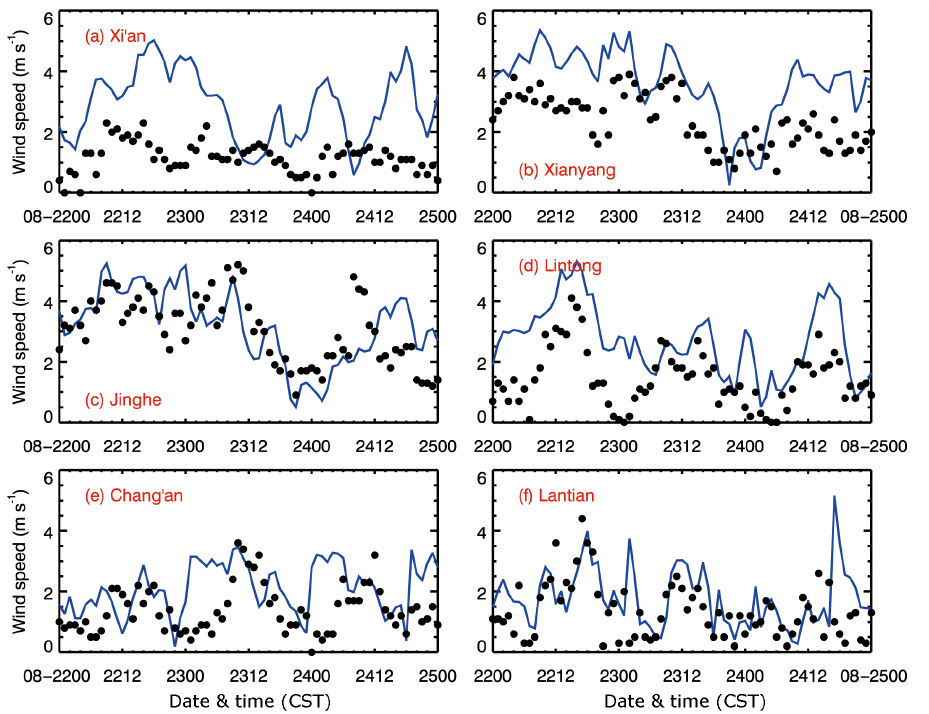
Figure 6. Observed (black dots) and simulated (blue lines) diurnal profiles of surface wind speeds at six meteorological sites from 22 to 24 August